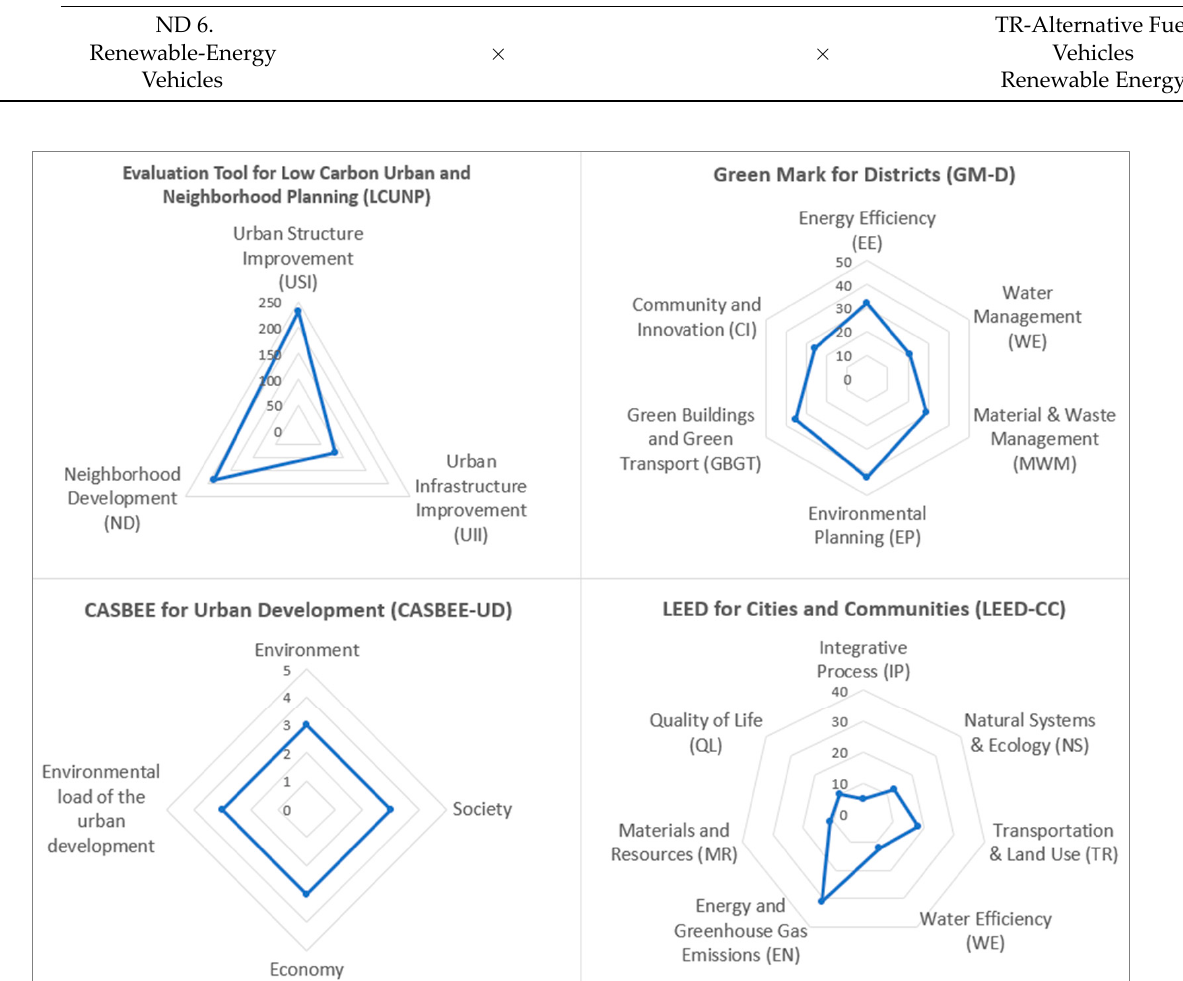
Figure 9. Credit distributions of the selected assessment tools.